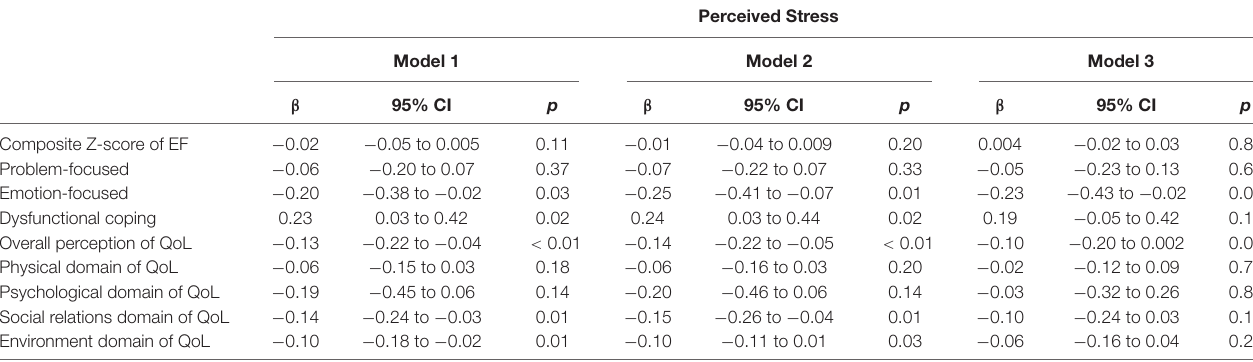
TABLE 2 | Association of perceived stress with executive function, coping strategies, and quality of life n =